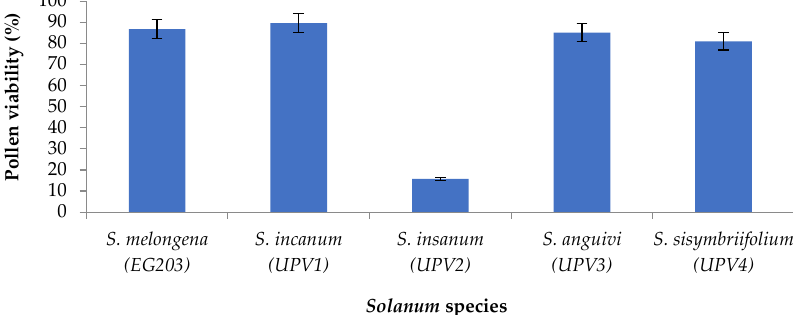
Figure 1. Pollen viability (%; mean ± SE) in cultivated eggplant ( Solanum melongena accession EG203) and wild accessions ( Solanum incanum UPV1, Solanum insanum UPV2, Solanum anguivi UPV3, and Solanum sisymbriifolium UPV4) used in interspecific hybridizations.